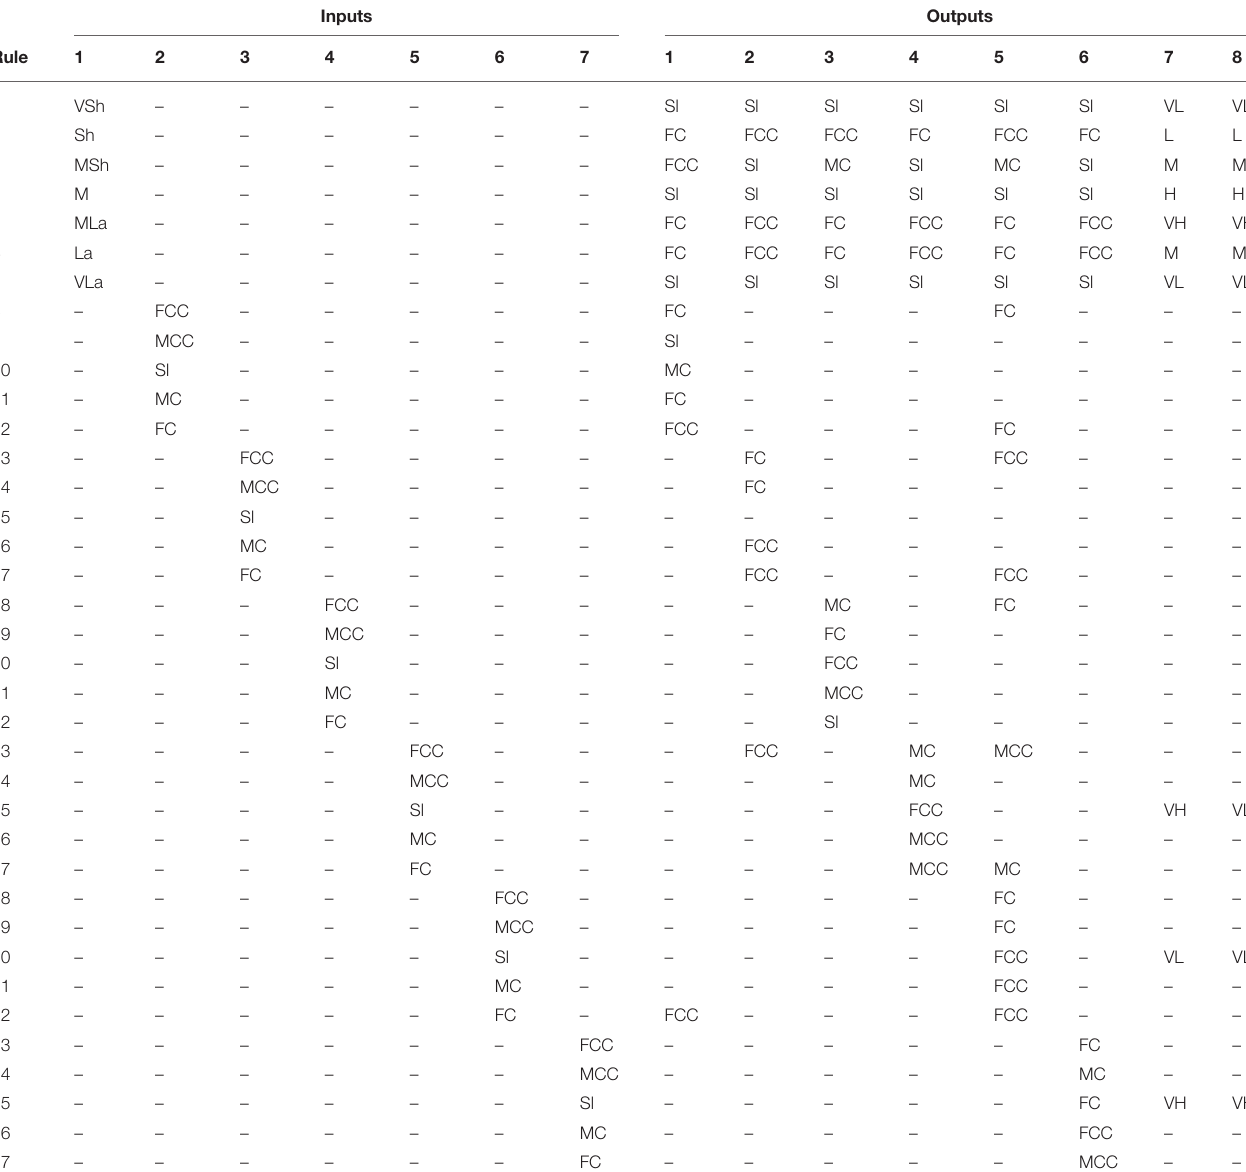
TABLE 8 | Fuzzy rules for Incerta , an acousmatic composition for eight